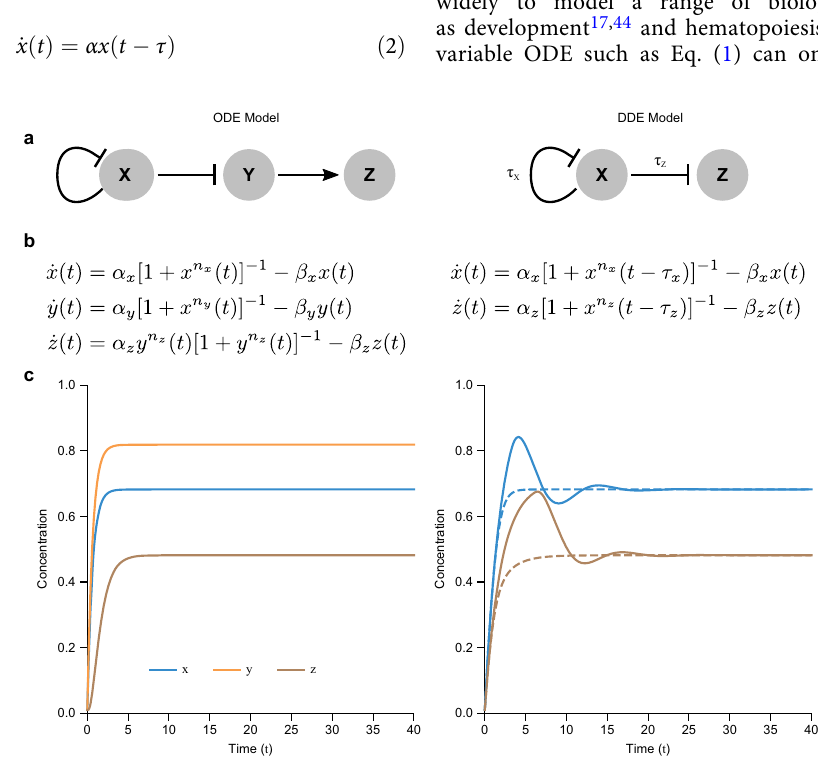
Fig. 1 Explicit inclusion of time delays in mathematical models of network motifs can reproduce non-delay models using fewer variables and parameters, but can also lead to more complex behavior. a An example genetic regulatory network including genes X , Y , and Z , regulated by one another either positively (activation, pointed arrow) or negatively (repression, blunt arrow). The model on the left incorporates no explicit delay terms, whereas the model on the right incorporates explicit delay terms τ x and τ z . b Ordinary differential equations (ODEs) and delay differential equations (DDEs) corresponding to ( a ) with regulation strengths α i , removal rates β i and cooperativities n i . c Numerical simulations of equations in ( b ) for one set of initial conditions using parameters α x = 1, α y = 1.2, α z = 1.2, β x = β y = β z = 1, n x = n y = n z = 2 for the ODE simulation, and α x = 0.5, α z = 0.3529, β x = β z = 0.5, n = n = 2 for the DDE simulations (dashed curves: τ = 0.8, τ = 0.1; solid curves: τ = 3, τ = 4). Note that delays can cause more complex dynamics x z x z x z (e.g., transient oscillations) compared to models in which effects are instantaneous, and where both models give the same long-term steady state behavior. Left: instantaneous effects modeled using ODEs, Right: delayed effects modeled using